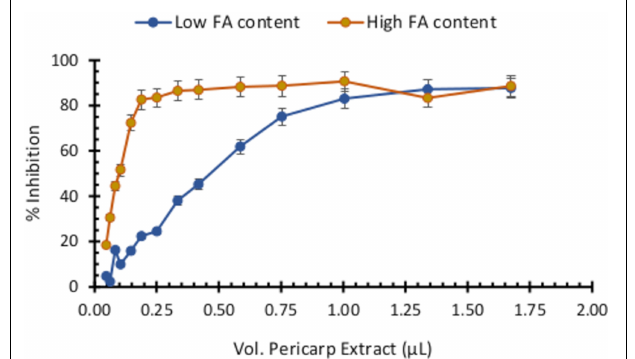
FIGURE 6 | Antioxidant capacity of pericarp extracts (PE) with high or low ferulic acid contents. Antioxidant activity was determined by the ABTS + assay through inhibition of absorbance at 450 nm. Pericarp extracts were prepared to reflect the same amount of biomass (mg pericarp/mL) with increasing volumes of each pericarp extract pipetted into the plate containing the ABTS +